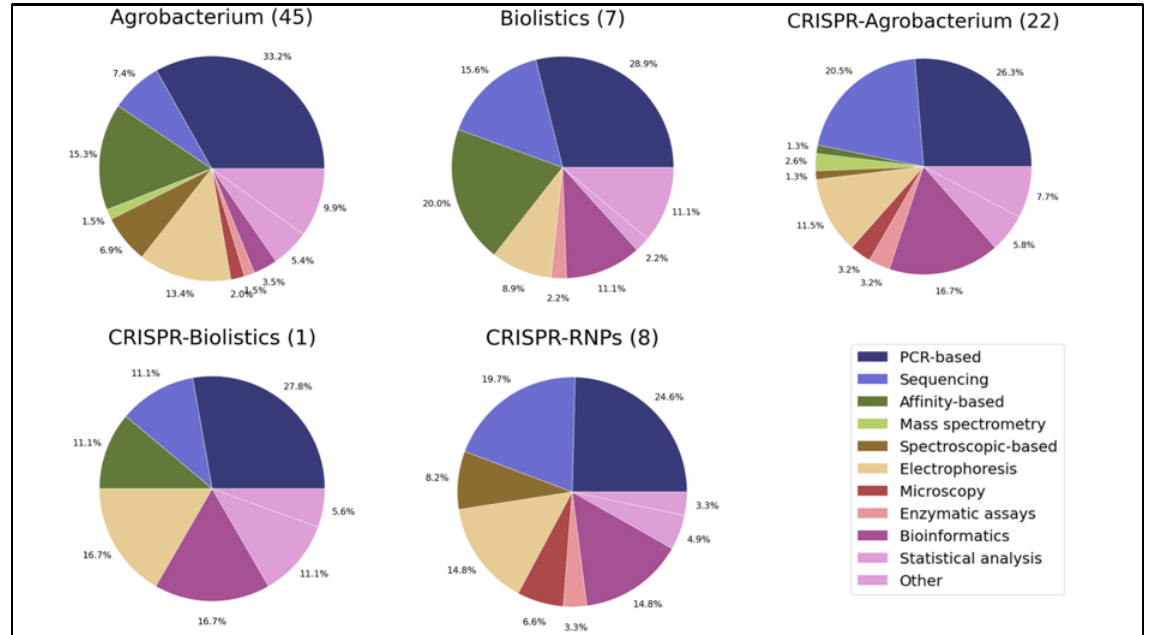
Figure 9. Analytical methods applied in the reviewed papers for the study of genetic outcomes of genetic engineering. Number of articles included in each method is represented within brackets next to the title of each pie chart. Each method is represented as a percentage of total number of methods. The “Other” category includes methods such as staining, field experiments, stress tests, etc.